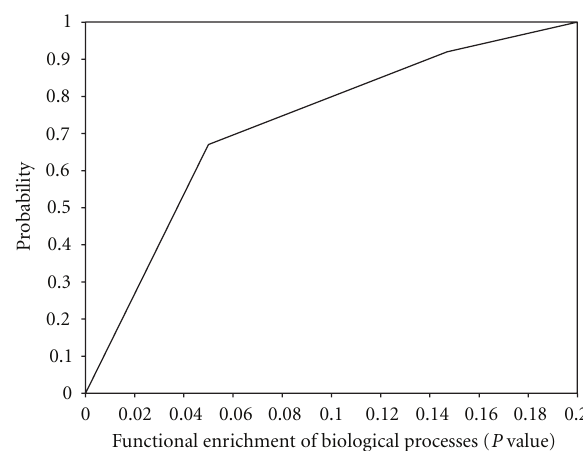
Figure 4: Cumulative distribution of P value in our detected paths. x -axis: P value, y -axis: percent of paths with corresponding P value or